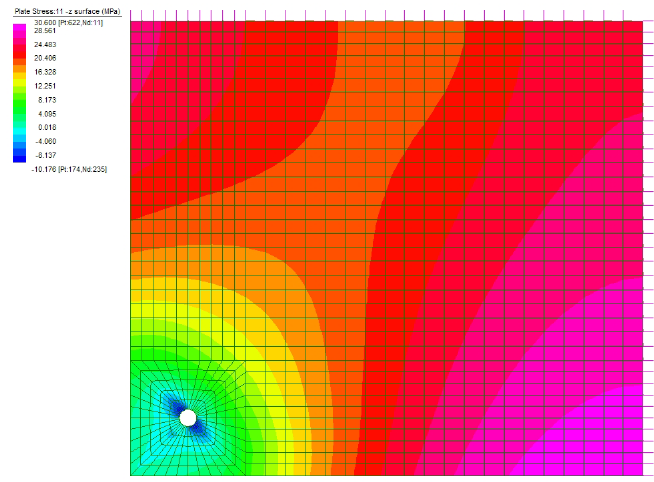
Figure 9: Principal max stress on glass pane (upper side) - σ max =30 MPa < f d =50